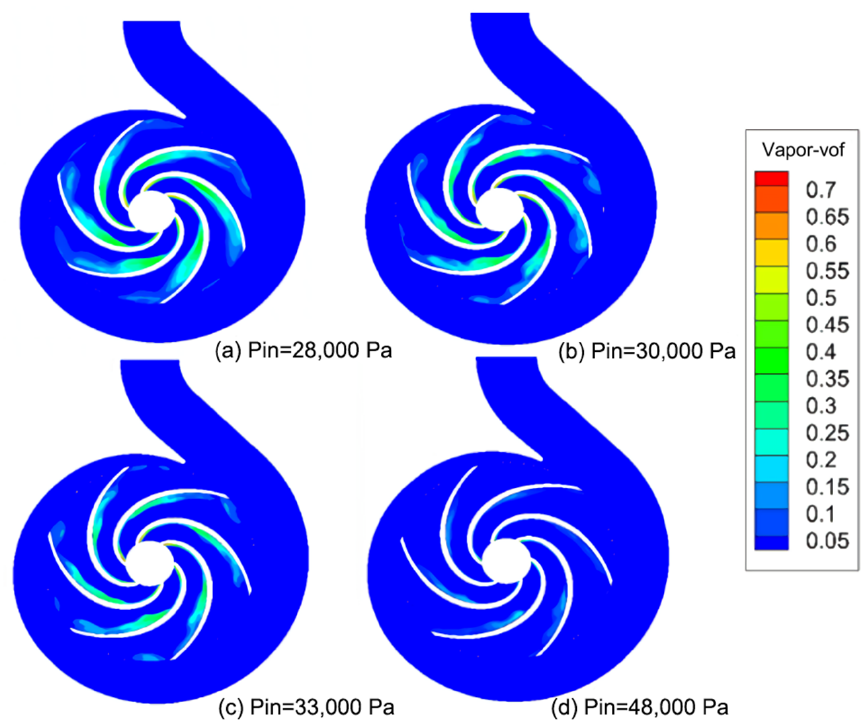
Figure 7. Relative velocity distribution at different NPSHs.